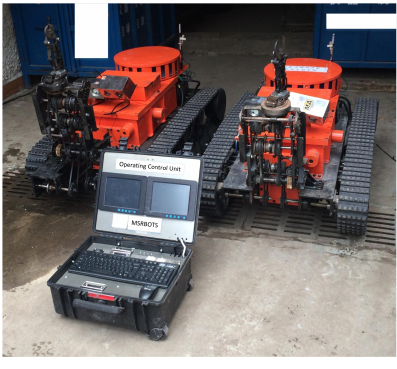
Figure 1. The search-and-rescue robot system used for remote sensing of the underground coal mine